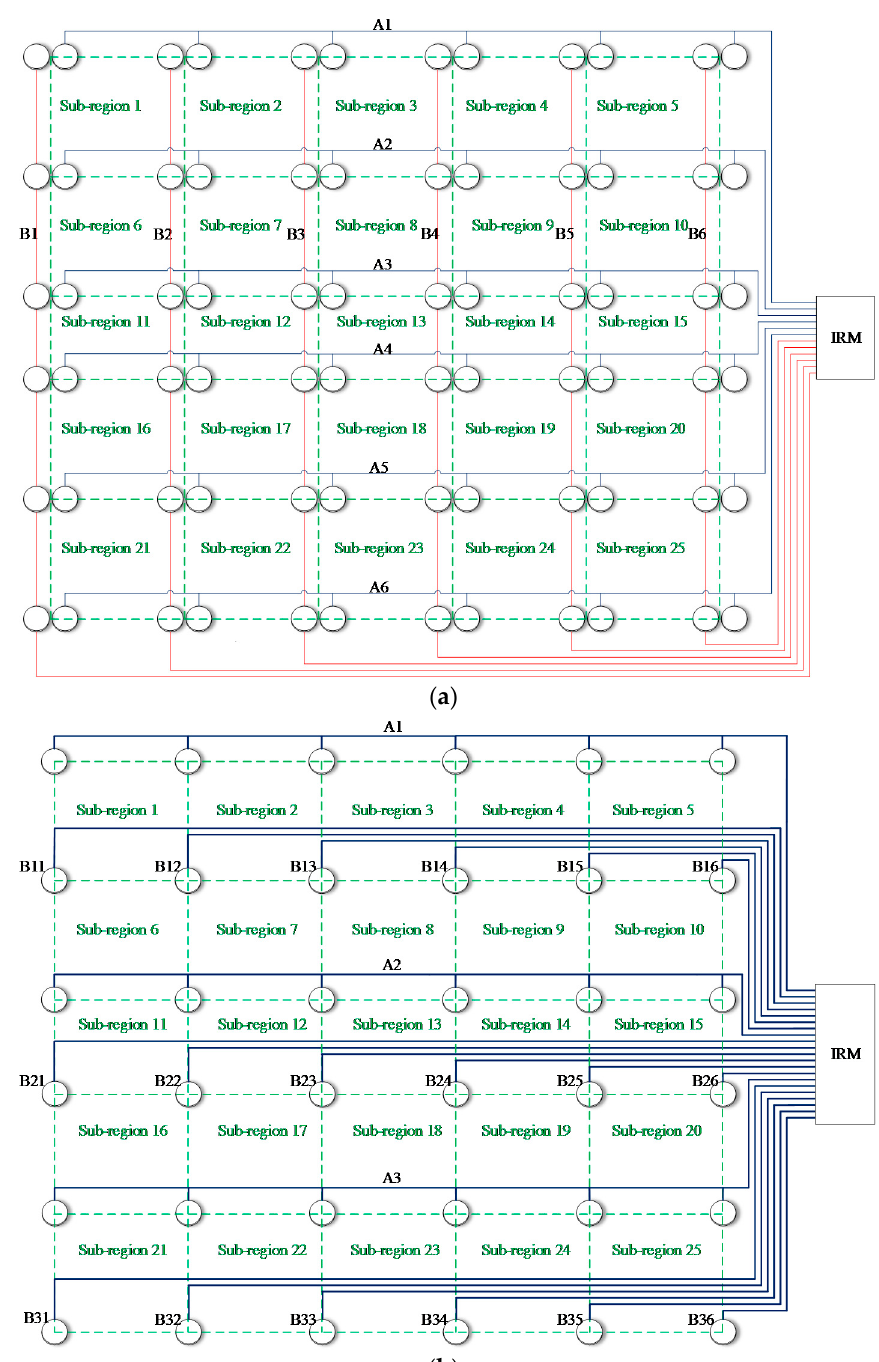
Figure 24. Schematic diagram of the lightweight sensor networks placed on the UAV composite skin: ( a ) CSSN/CPSN and ( b ) CHSN.